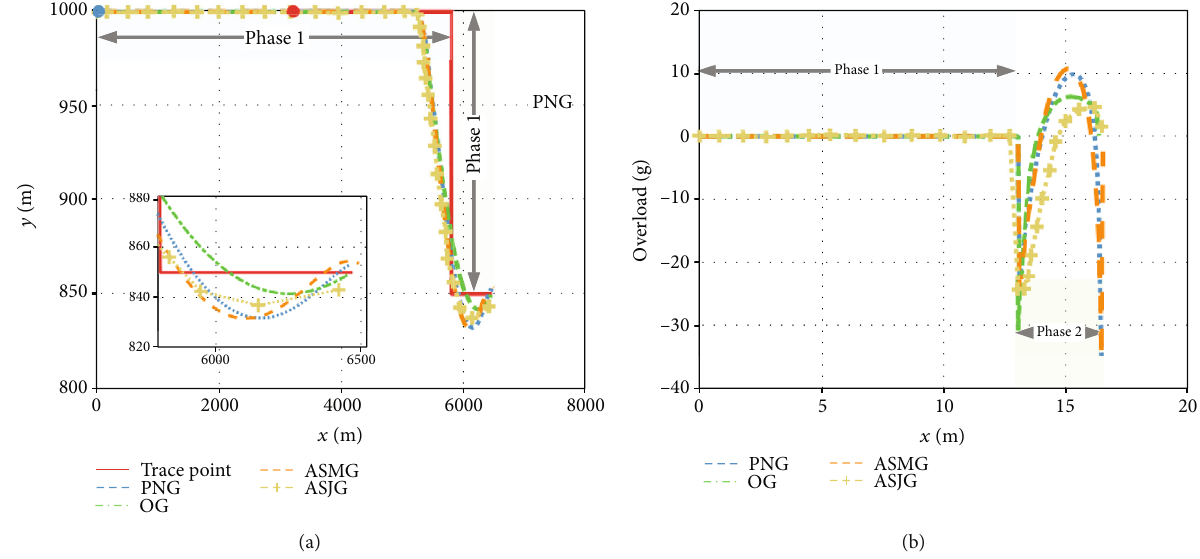
Figure 17: The variation of the state for the single-jump system in the tail-on scenario. (a) Trajectories of the missile and trace point; (b) overloads of di ff erent guidance